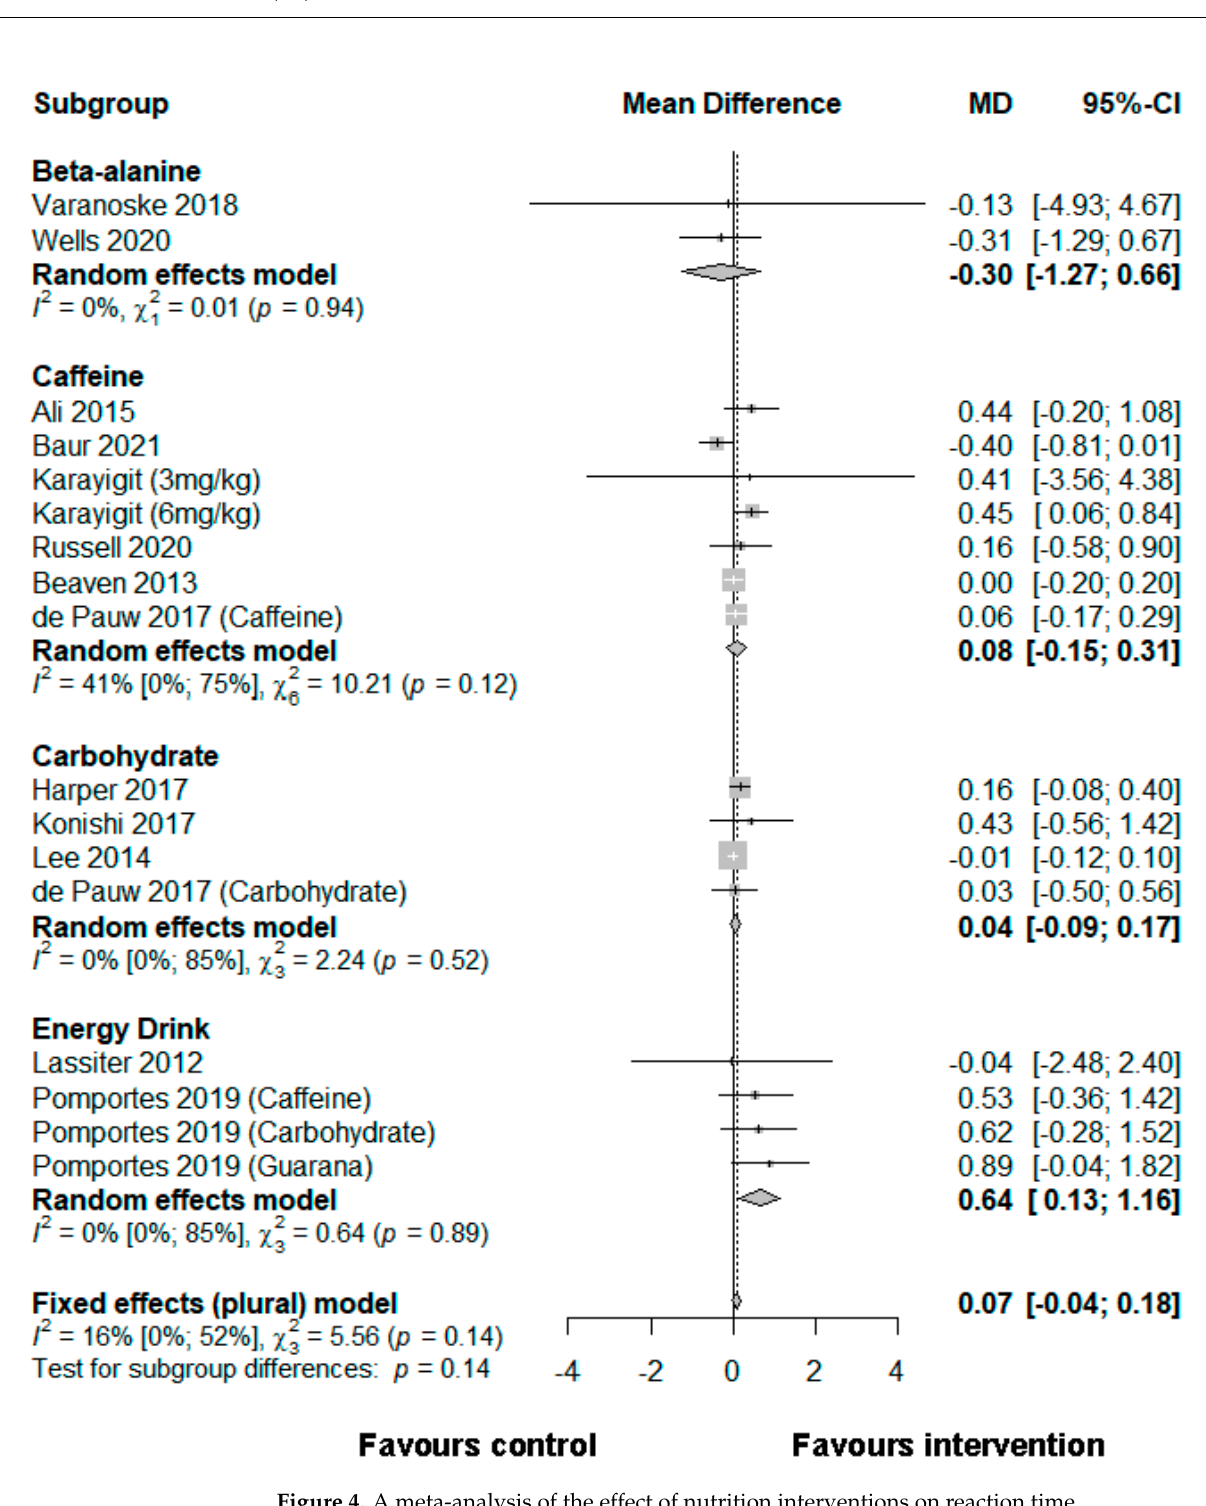
Figure 4. A meta-analysis of the effect of nutrition interventions on reaction time.